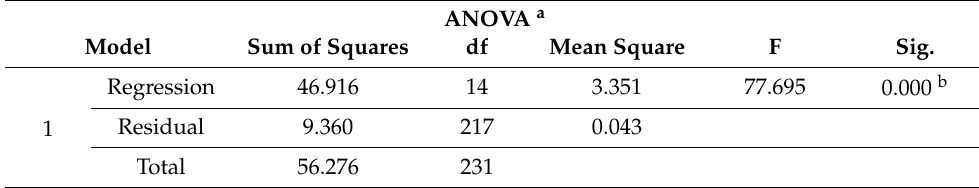
Table 3. ANOVA Test for